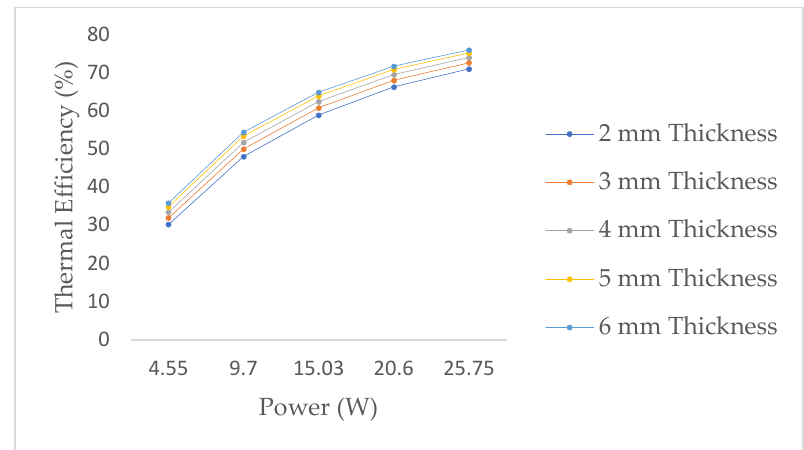
Figure 11. Thermal efficiency relative to the power input.